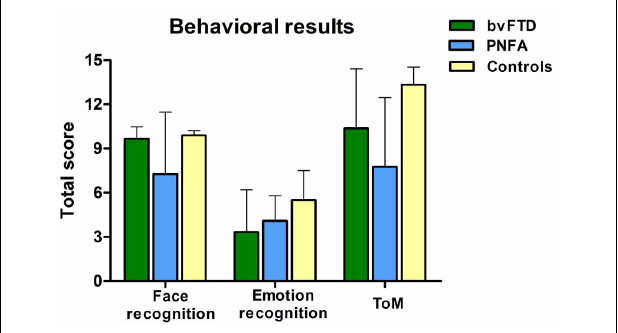
FIGURE 1 | Scores of three behavioral tasks of face and emotion recognition and ToM. PNFA patients in light blue, bvFTD patients in green, and controls in